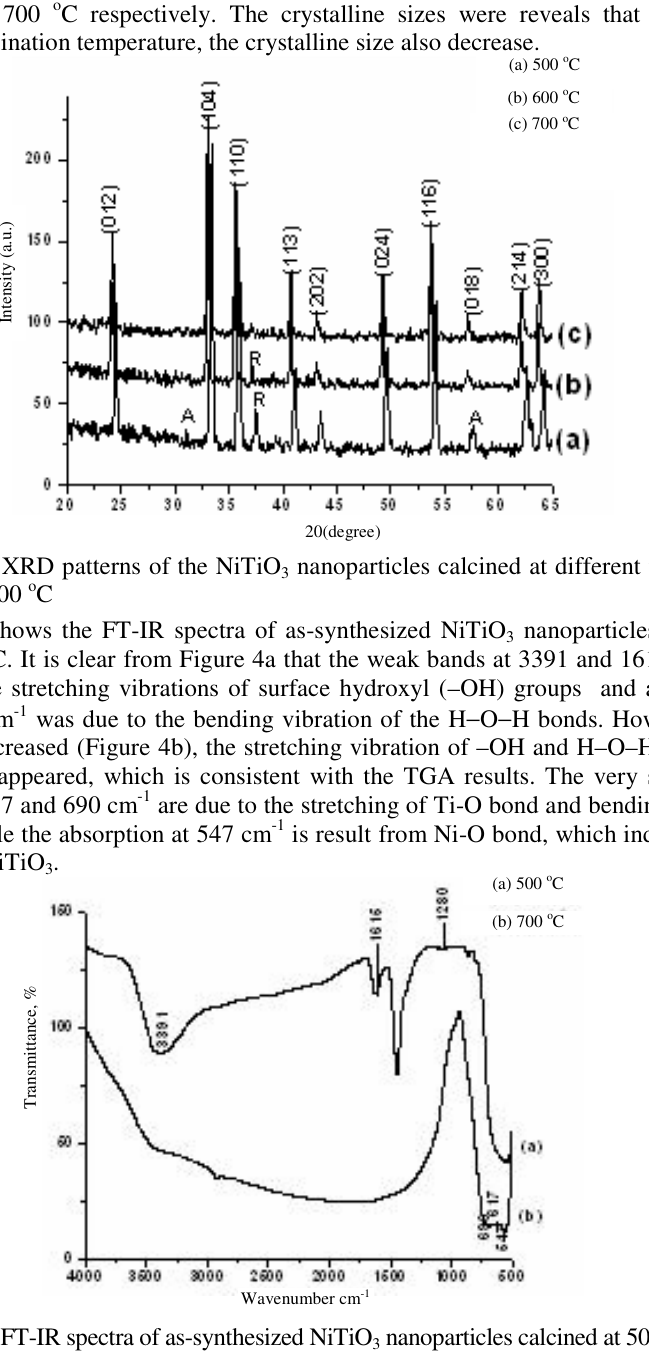
nanoparticles calcined at 500 and 700 o 3